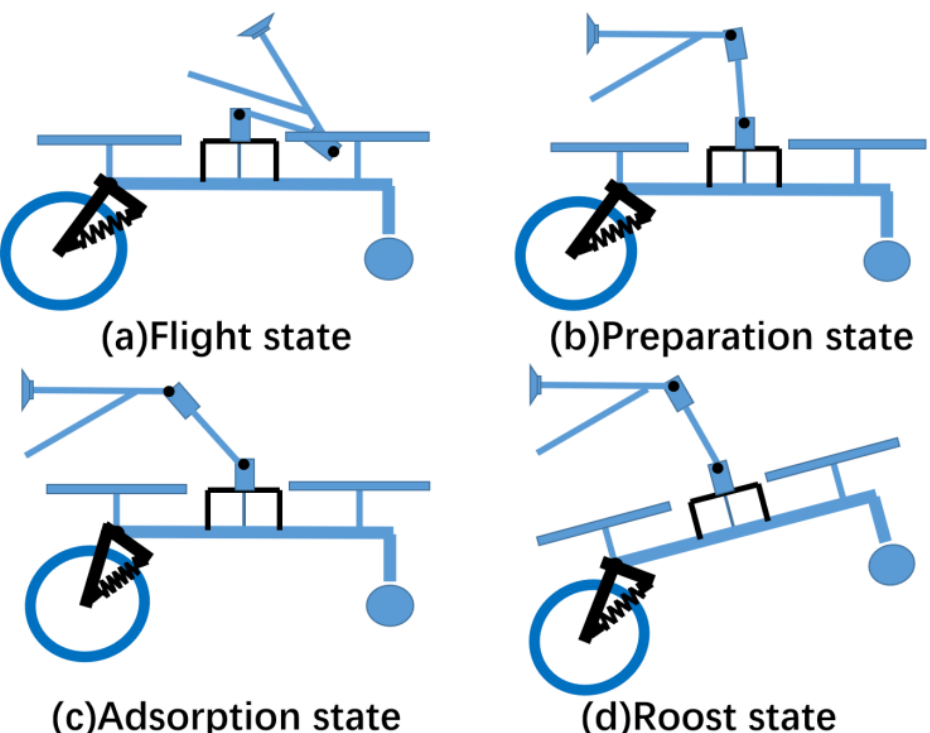
Figure 3. Four working states of the robot (LAWCDR). ( a ) Flight state. ( b ) Preparation state. ( c ) Adsorption state. ( d ) Roost state.